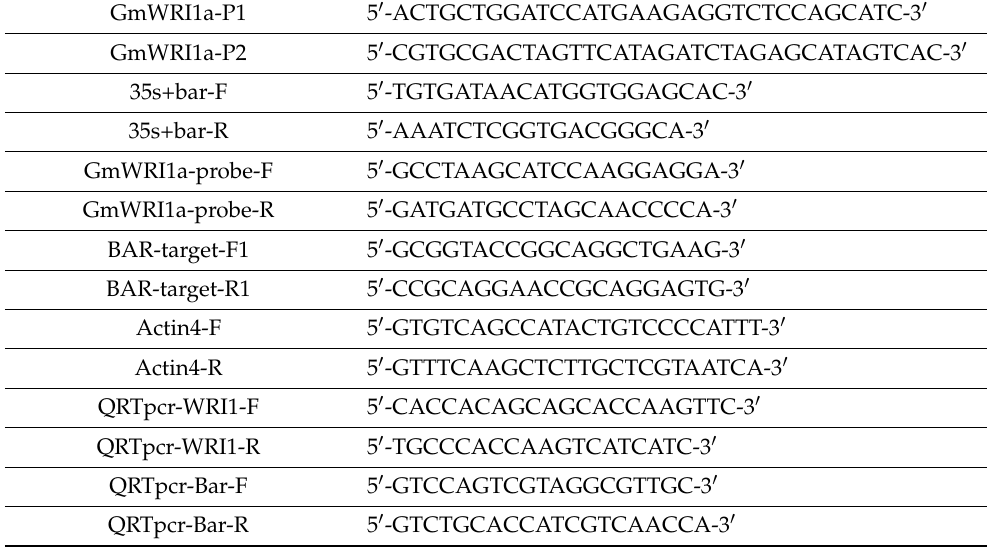
Table A1. Primer pairs used in the study.